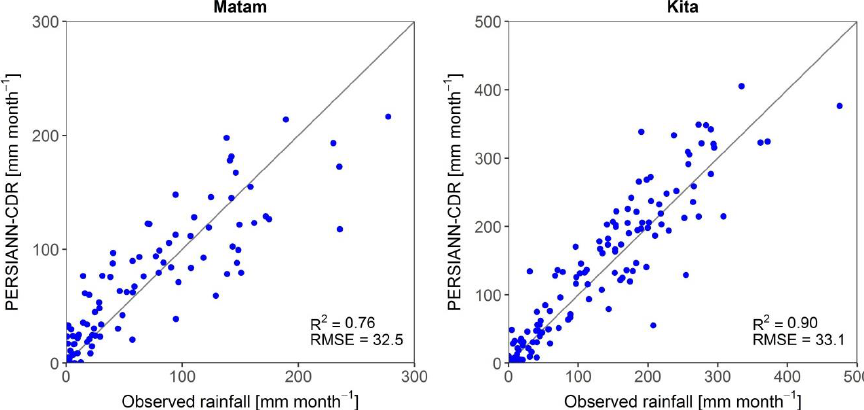
Figure 3. Sample of scatter-plots of monthly PERSIANN-CDR and gauged rainfalls.